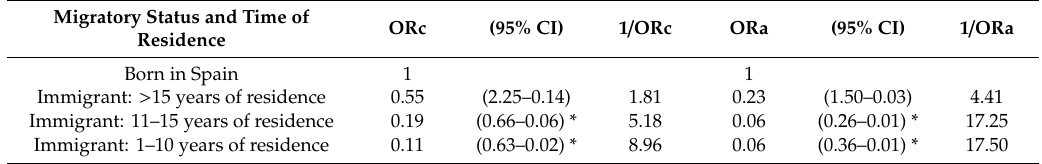
Table 4. Association (crude odds ratio (ORc) and adjusted odds ratio (ORa) with 95% confidence intervals (95% CI)) of common mental disorders in immigrants by time of residence versus residents born in